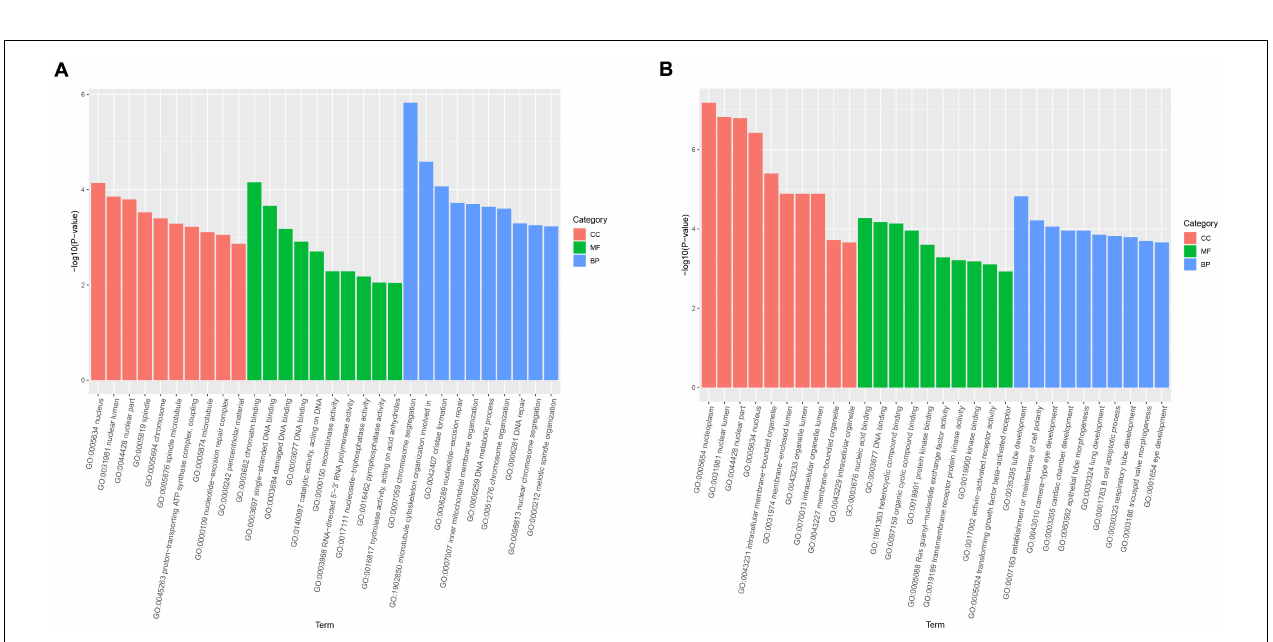
FIGURE 3 | Gene Ontology analysis of host genes of DE-circRNAs. GO analysis of the DE-circRNAs in (A) HCT8/5-Fu cell lines and (B) HCT8/DDP cell lines.